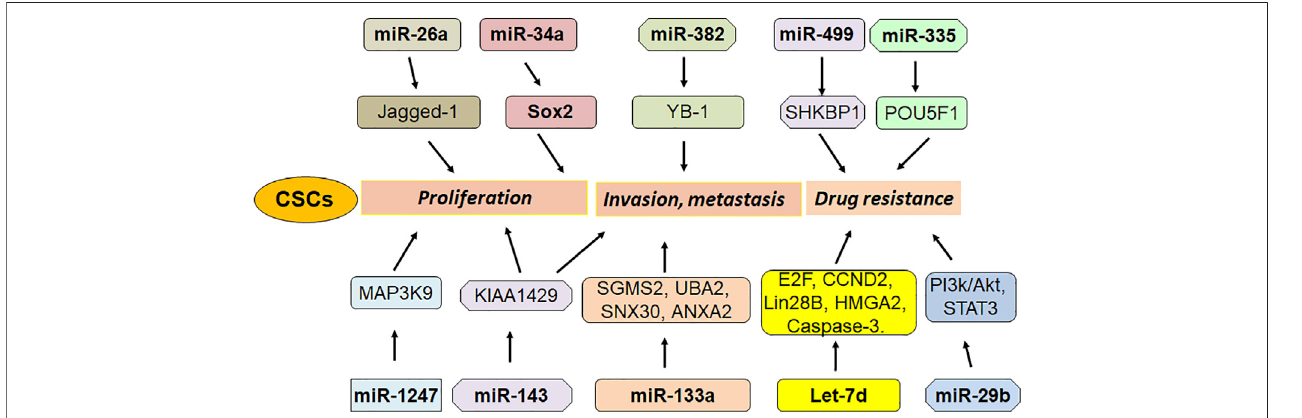
FIGURE 1 | The role of miRNAs in regulation of OS stem cells.